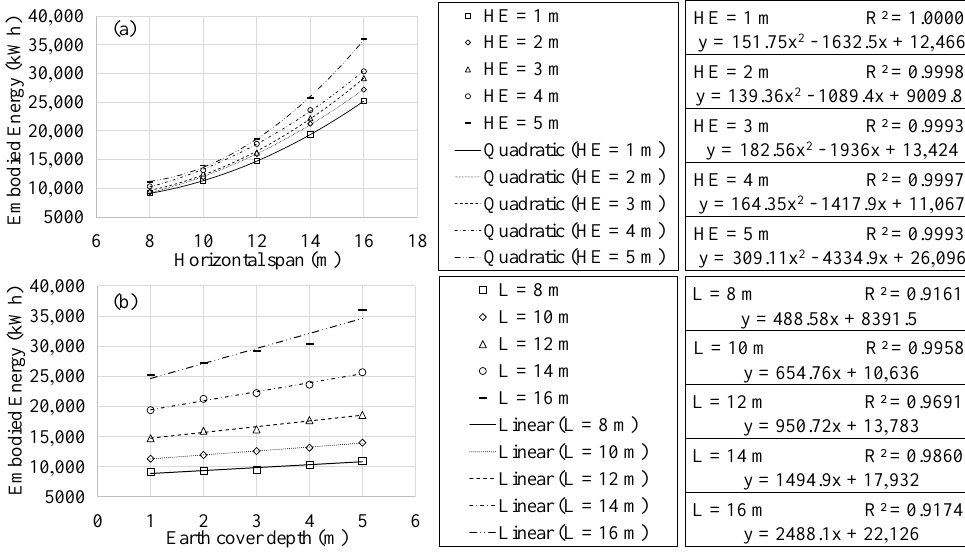
Figure 6. Embodied energy analysis as a function of: ( a ) horizontal span; ( b ) earth